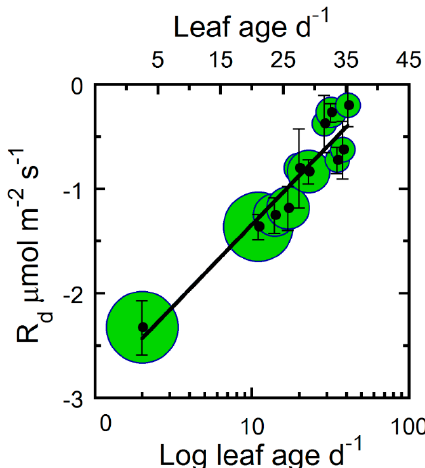
Figure 2. The leaf respiration rate (R d ) of hemp leaves as a function of leaf age. The log base of leaf age and leaf age (primary and secondary x -axis, respectively). Binned averages per three-day collection sequence (means ± SE), where samples were pooled for treatments and crown position, and sample size in bins is indicated by the bubble diameter (n = 3–18 for R d ). Solid line is a linear regression fitted to the entire data set.